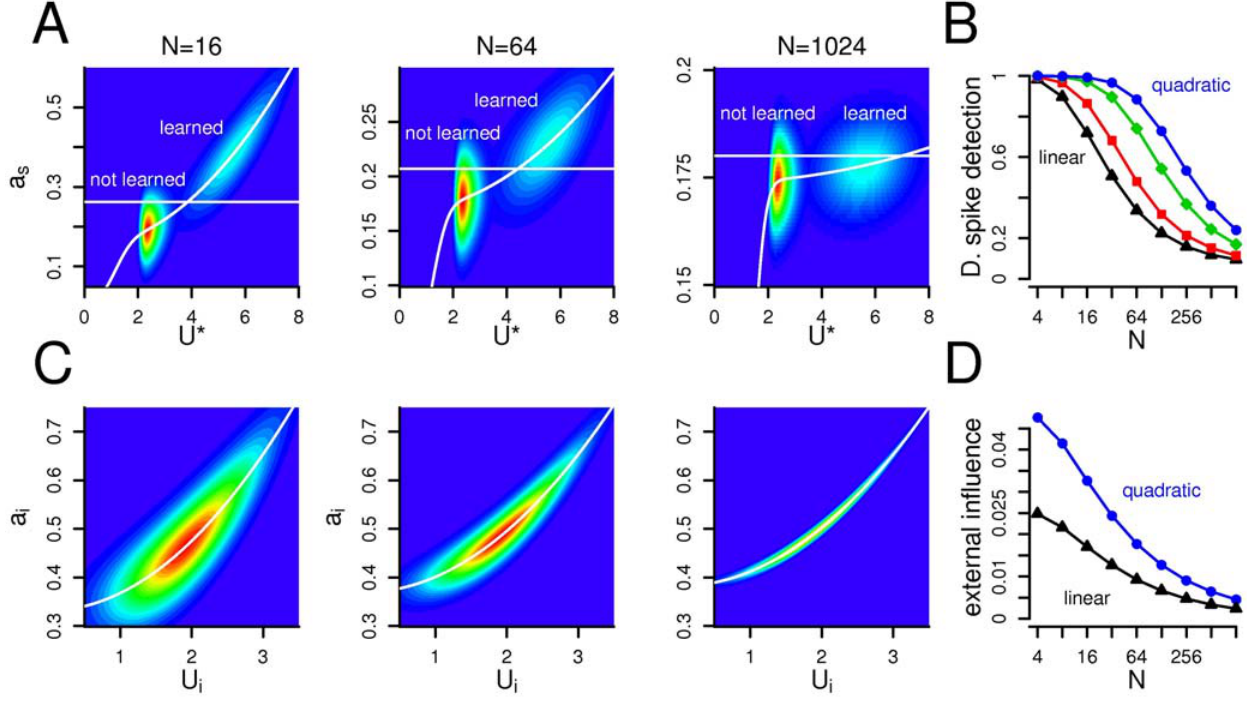
Figure 5. Moderate number of branches allows the isolation of subunits and the detection of dendritic spikes. (A) The joint distribution of the somatic activation as and the maximal dendritic input U * . As the number of branches grow (from left to right), the somatic depolarization caused by a dendritic spike in a single compartment decreases gradually. Consequently, if N is high, than the somatic threshold (horizontal line) can not separate small and large dendritic events. (B) The probability of detecting a dendritic spike decreases as the number of dendritic subunits increases. Different colors indicate different degrees of nonlinearity (blue circles: quadratic; black triangles: linear integration function). (C) The joint distribution of the activation of a dendritic branch a i and its own input U i . Increasing the number of compartments decrease the variance of the distribution and the impact of other branches. (D) The external influence decreases with the number of branches both with linear (triangles) and quadratic (circles) integration function. R =0.3.